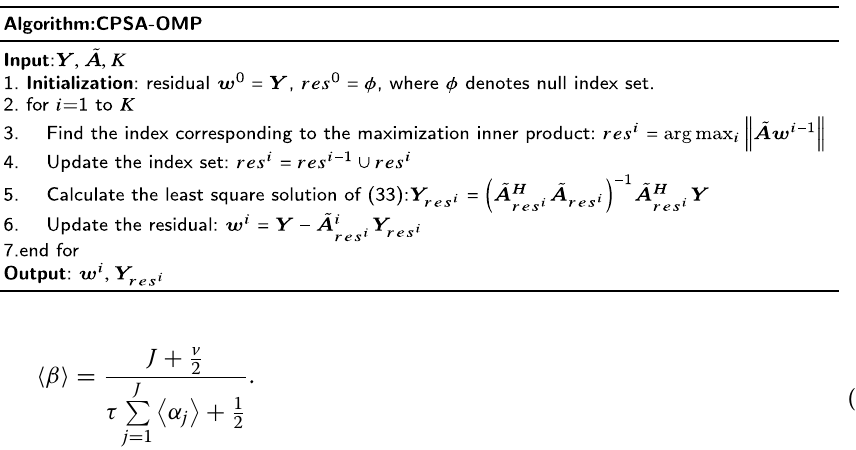
Table 2 The execution steps of CPSA-OMP